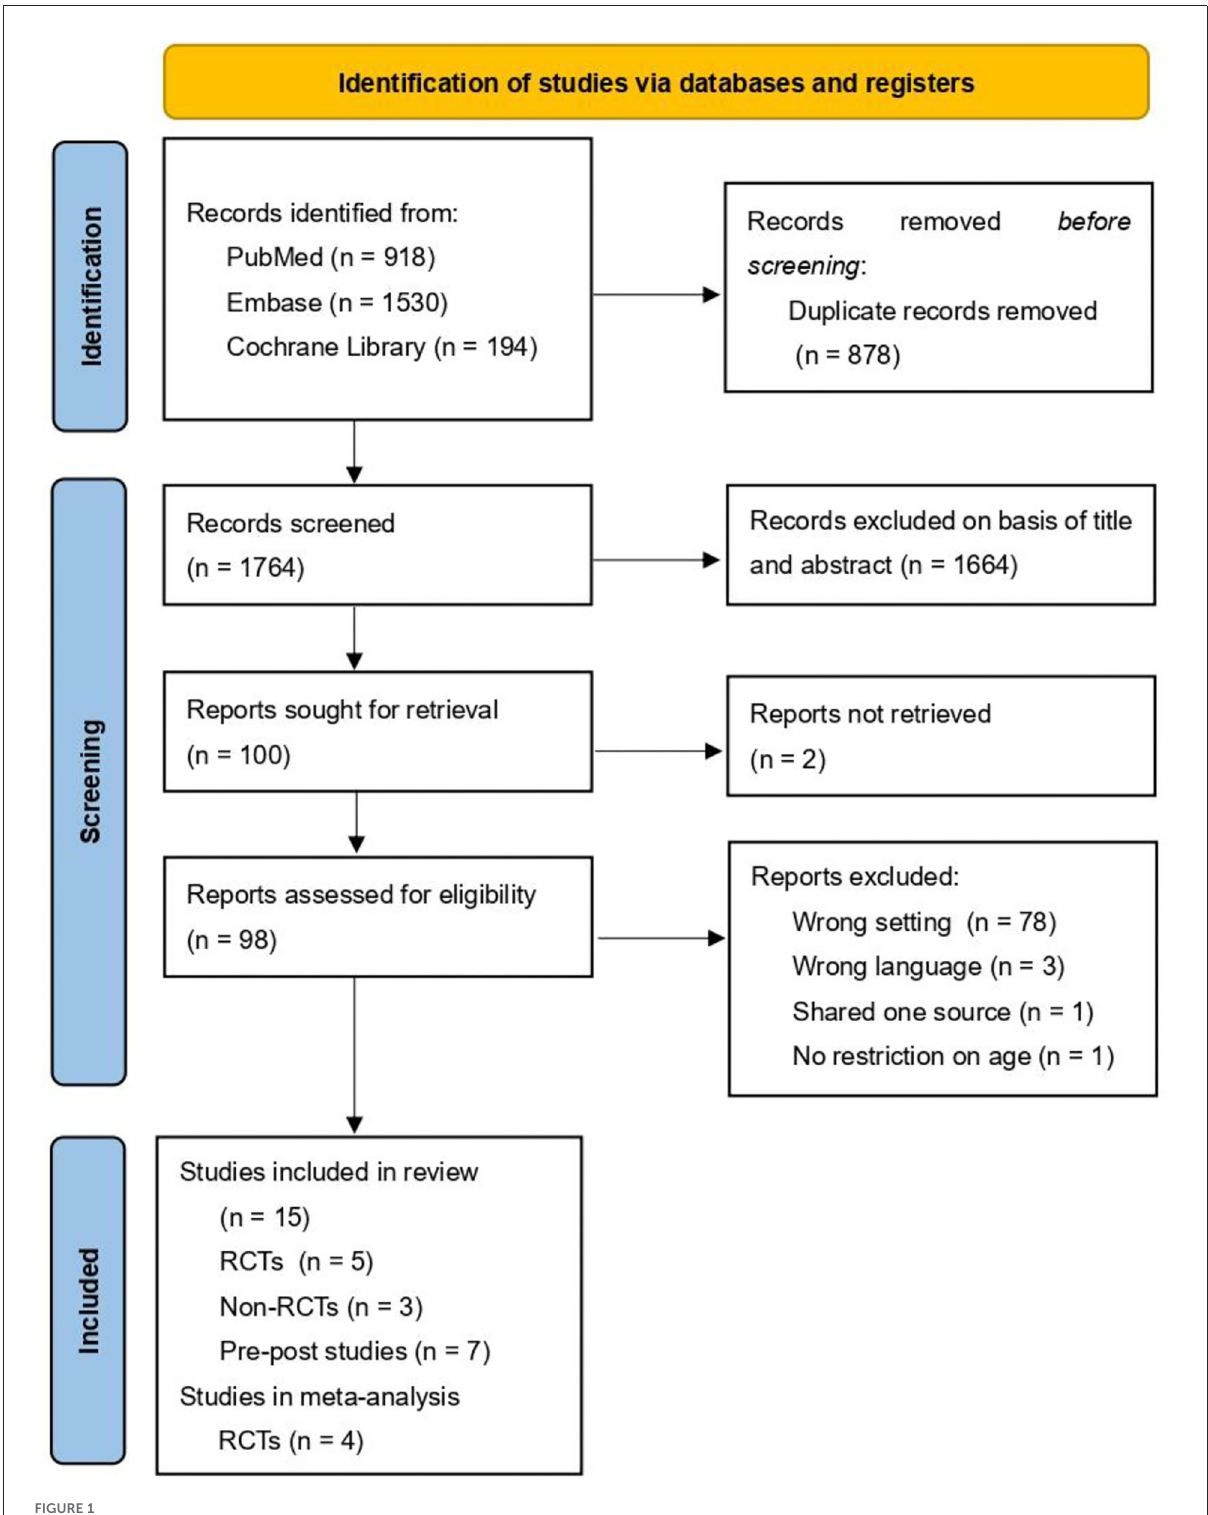
FIGURE1 Preferred Reporting Items for Systematic Reviews and Meta-Analyses (PRISMA) flow